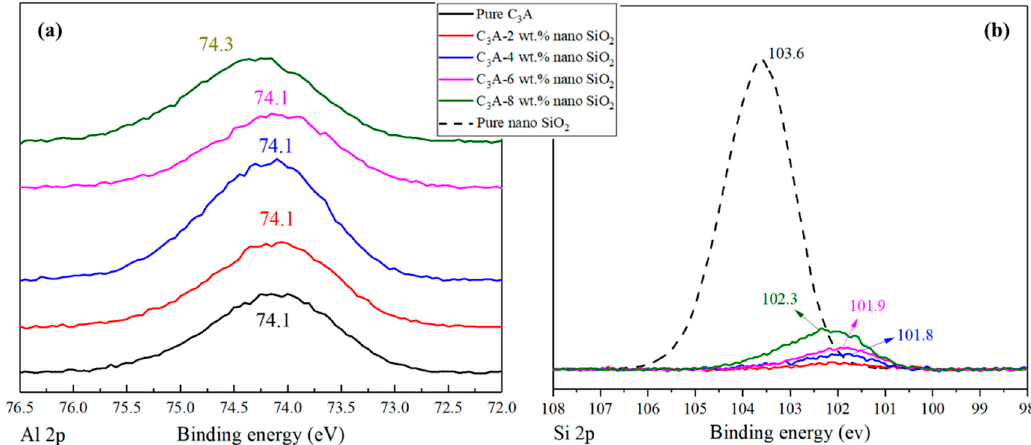
Figure 4. XPS results of ( a ) Al 2p and ( b ) Si 2p for hydration products of pure C 3 A and C 3 A with different nano SiO 2 contents.